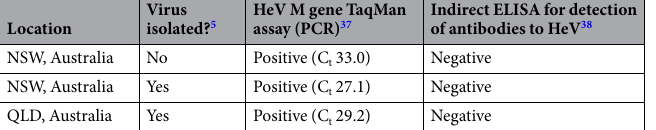
Table 1. Diagnostic test results for horses infected with HeV analyzed in this